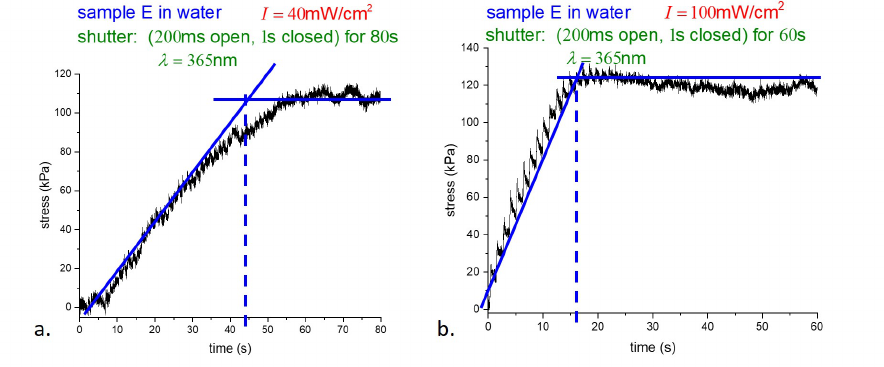
Figure 6. Photostress in water at different intensities at ( a ) 40 mW/cm 2 and ( b ) 100 mW/cm 2